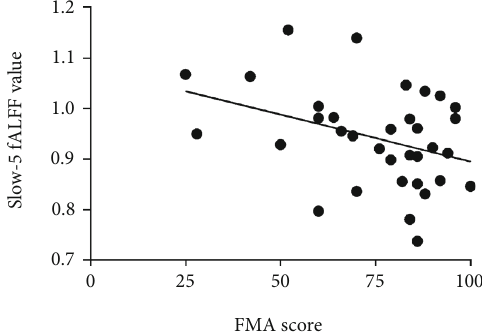
Figure 4: Abnormal cluster of the fALFF was signi fi cantly correlated with FMA score in BGIS patients in the slow-5 band ( p < 0 : 05 ). BGIS: basal ganglia ischemic stroke; fALFF: fractional amplitude of low frequency fl uctuation; FMA: Fugl-Meyer Assessment